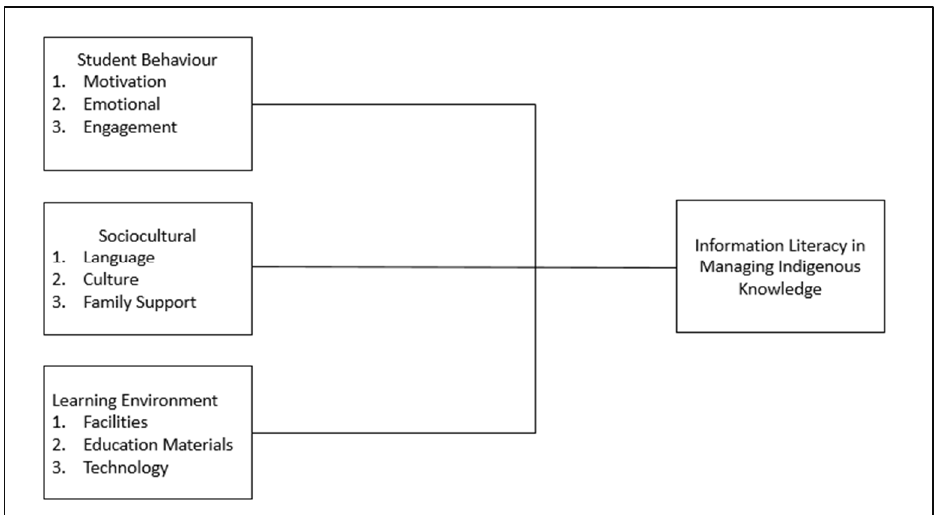
Figure 1. Research framework of the